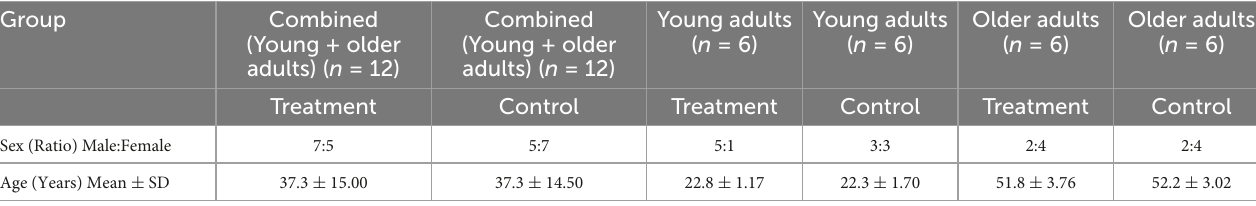
TABLE 2 The demographic characteristics of all participants.